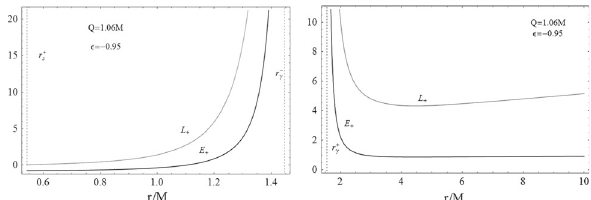
√ Fig. 24 Class : M < Q ≤ 9 / 8 M and − 1 < (cid:2) < − M / Q . Parameter choice is as follows: Q = 1 . 06 M and (cid:2) = − 0 . 95. Then r + s = 0 . 542901 M , r − γ = 1 . 44708 M , and r + γ = 1 . 55292 M . Circular orbits exist with angular momentum L = L + ( gray curve ) and energy E = E + ( black curve ) in r + s < r < r − γ ( left plot ) and in r > r + γ for ( right plot ). For r = r + s , L = 0